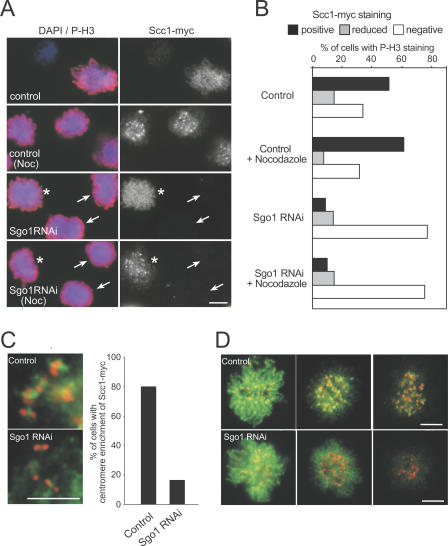
Sgo1 Is Required for Stable Association of Cohesin at Centromere(A) Synchronised HeLa cells that inducibly express Scc1-myc were transfected with control or Sgo1 siRNA and processed for immunofluorescence microscopy with or without 4-h treatment with nocodazole. Mitotic cells were spun down on glass slides and analysed for cohesin with antibodies to myc epitope (right photomicrographs). Cells were costained with P-H3 (left photomicrographs, red) to identify cells from prophase to metaphase. DNA was counterstained with DAPI (left photomicrographs, blue). Note that with Sgo1 RNAi, Scc1-myc was undetectable in the majority of P-H3 positive cells (arrows). Cells with myc staining are indicated as staining controls (asterisks). Bar = 10 μm.(B) Quantification of Scc1-myc staining. Approximately 200 cells with positive staining for P-H3 were assessed for Scc1-myc staining, which was classified as positive, reduced, or negative, as indicated.(C) Lack of centromere enrichment of cohesin in Sgo1-depleted cells. Mitotic cells were prepared as in (A), and the centromeric enrichment of Scc1-myc was analysed by immunofluorescence microscopy. Merged pictures of Scc1-myc (green) and CREST antigen (red) are shown. Approximately 200 cells were scored for each experiment. Bar = 5 μm.(D) Centromeric cohesin is not maintained in Sgo1-depleted cells. Mitotic cells were prepared and processed for immunofluorescence as in (C). Representative cells with various levels of Scc1-myc are shown. Note that centromeric staining of Scc1-myc emerges as the bulk of cohesin dissociates from chromosomes in controls (upper panels). However, in Sgo1 RNAi cells, centromeric enrichment is hardly seen at any stage of arm cohesin dissociation (lower photomicrographs). Bar = 10 μm.